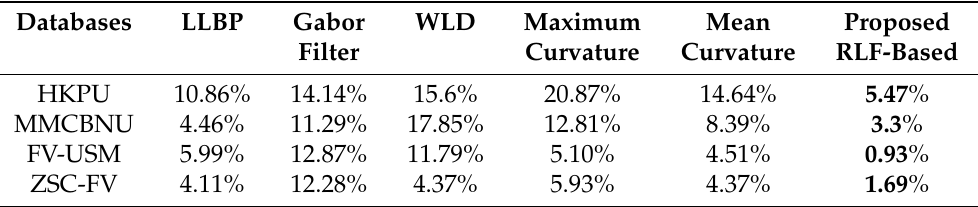
Table 4. EERs obtained by using different methods on four finger vein databases, the margin parameters are c w = 40, c h =